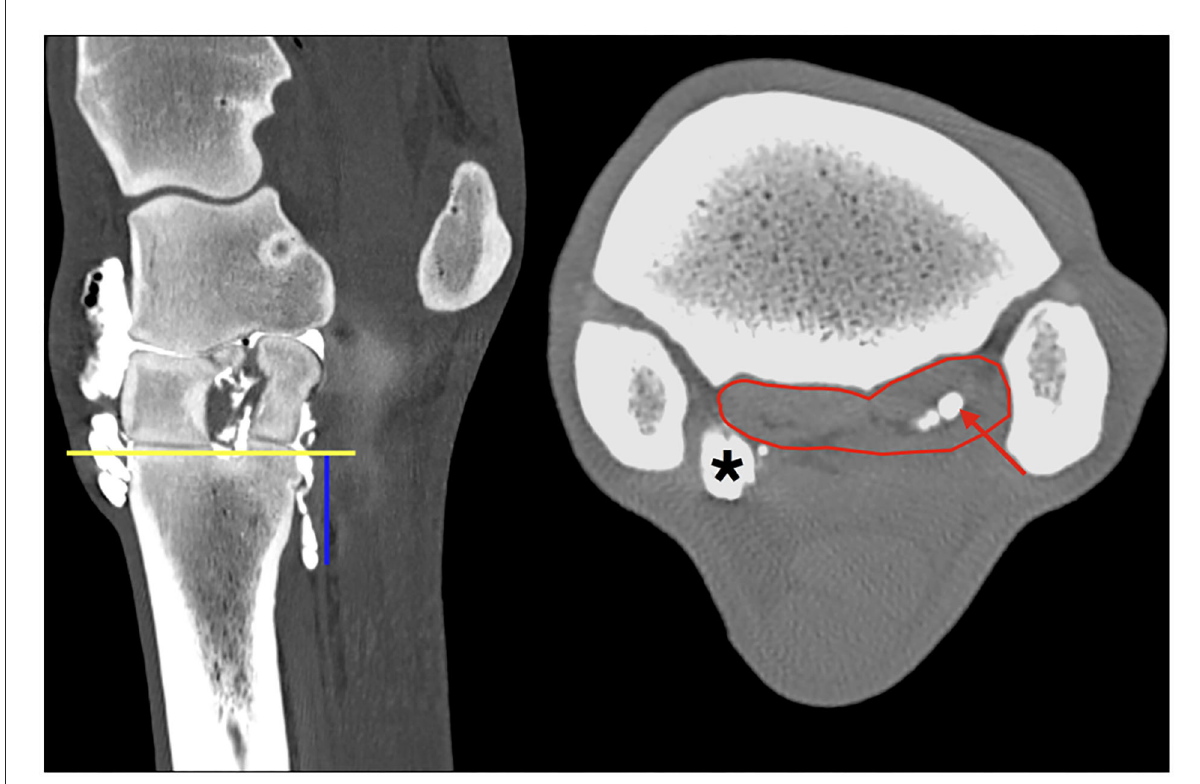
FIGURE1 Multiplanar reconstruction (MPR) of the CT arthrogram in transverse (right) and sagittal (left) planes following injection of positive contrast medium into the middle carpal joint; medial and dorsal are to the left. The region of interest is defined by a polygon (red line) outlining the borders of the PSL at the level 2.5cm (blue vertical line) distal to the proximal subchondral bone plate of the third metacarpal bone (yellow horizontal line). Note the positive contrast medium (red arrow) is evident in the center of the lateral lobe only, in the region of the muscle and fat tissue bundles, at this level of the PSL. Particularly, the medial palmarodistal outpouching of the carpometacarpal joint is evidently filled with positive contrast medium in the periphery (asterisk) adjacent to the axial aspect of the